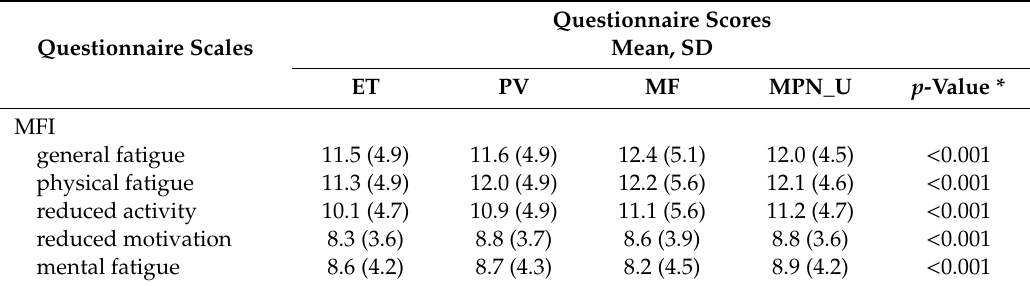
Table 4. Characterization of fatigue. Di ff erences between participants with di ff erent MPN